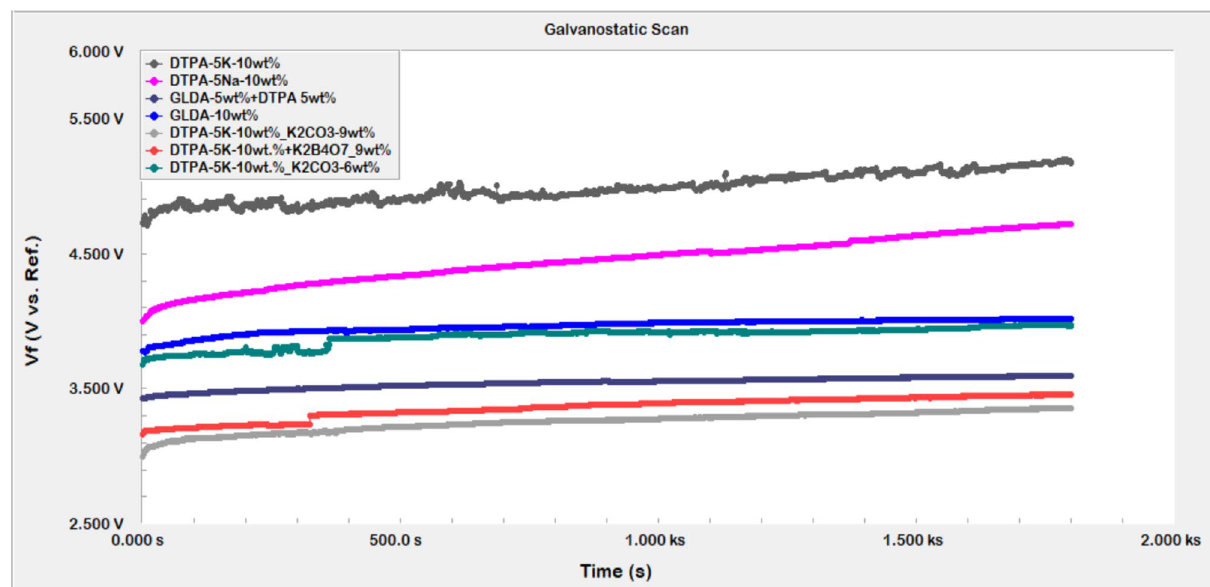
Figure 8. Effect of chemical formulations on the potential–time relationship of